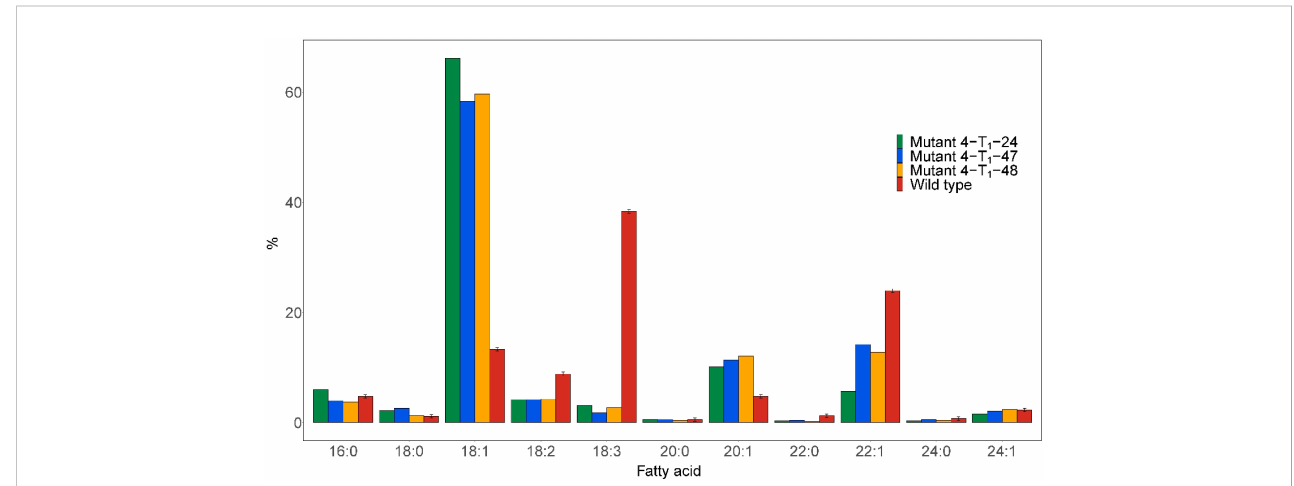
FIGURE 4 Major fatty acid compositions of seed oil from the individual seeds analyzed by the half-seed method exhibiting the most pronounced changes in fatty acid pro fi le. Seeds were derived from sel fi ng the heterozygous Mutant 4, as shown in Figure 1.